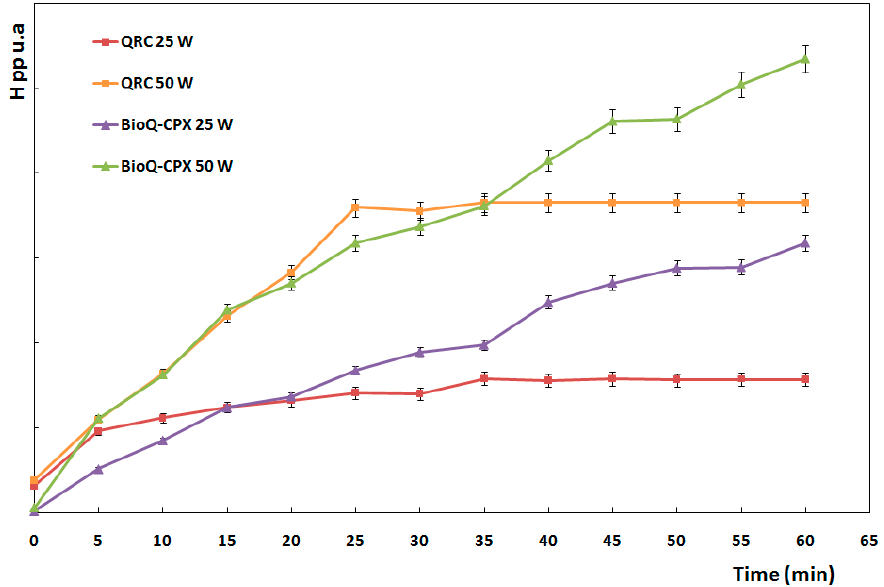
Figure 14. H pp values as a function of UV irradiation time (25 W and 50 W lamps) for pure QRC (squares) and BioQ-CPX nanocomposite (triangles); means ± SE ( n =